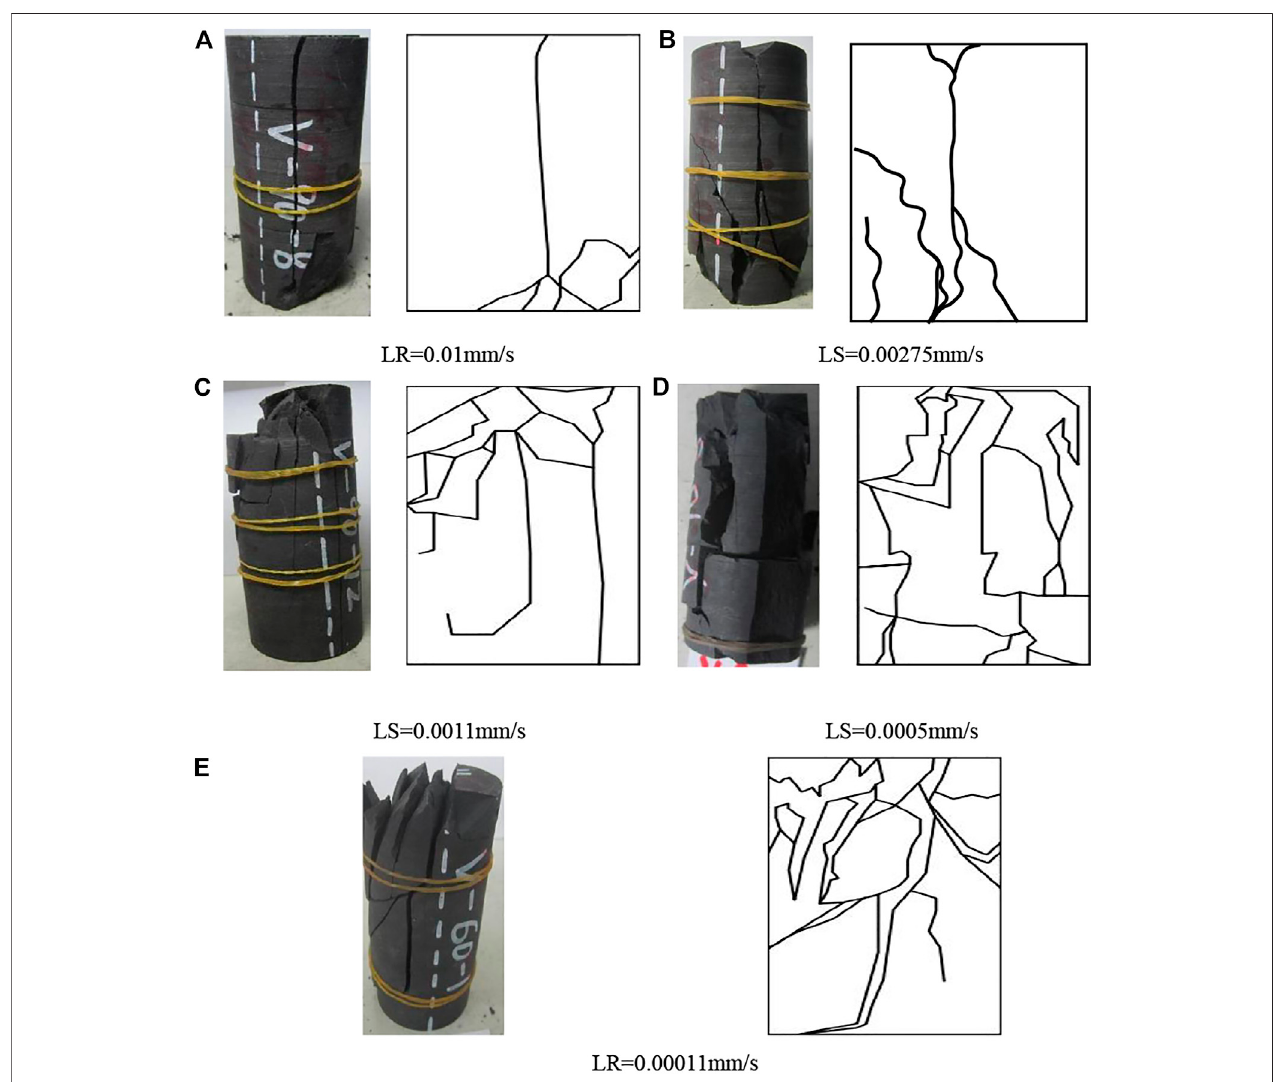
FIGURE 10 | Failure modes and schematic diagrams at different loading rates (LR is short for loading rate, all the samples have a diameter of 5 cm and a length of 10 cm). (A) LR=0.01 mm/s. (B) LS=0.00275 mm/s. (C) LS=0.0011 mm/s. (D) LS=0.0005 mm/s. (E) LR=0.00011 mm/s